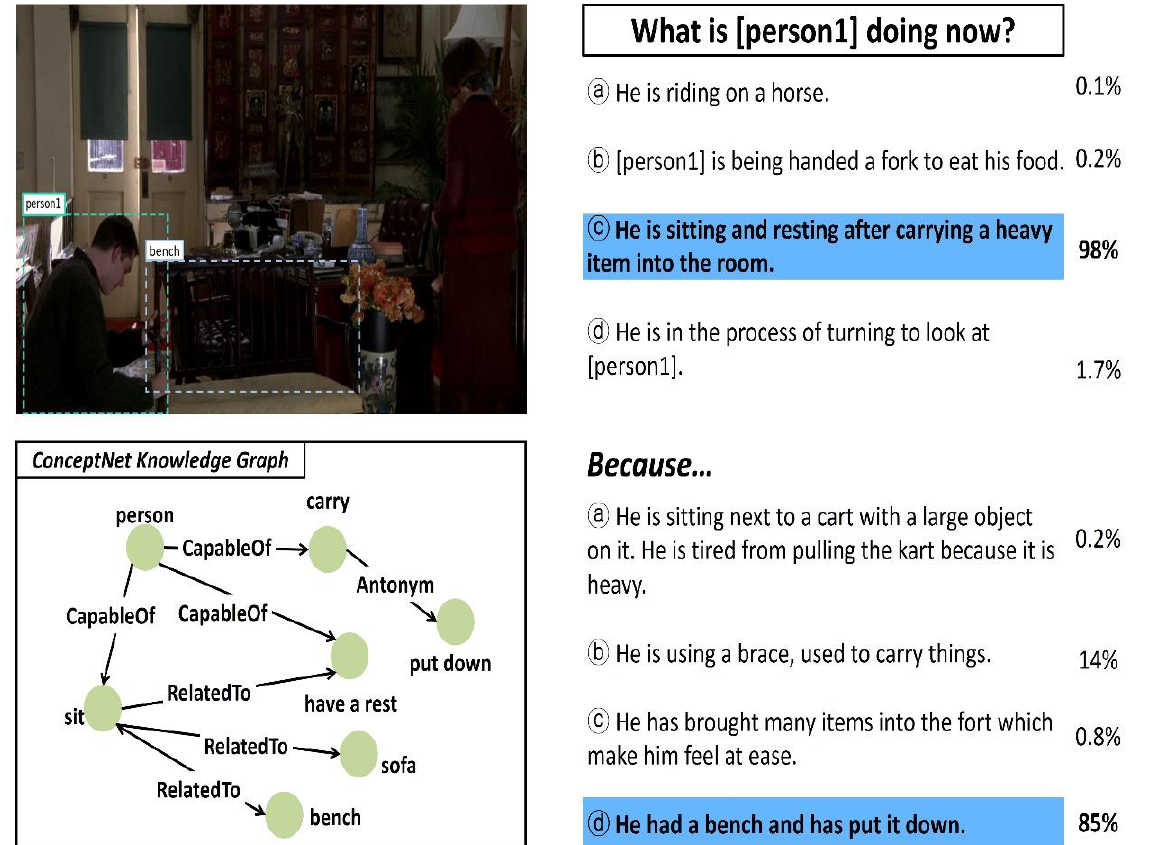
Figure 9. The first example of VCR task performed by the proposed model.